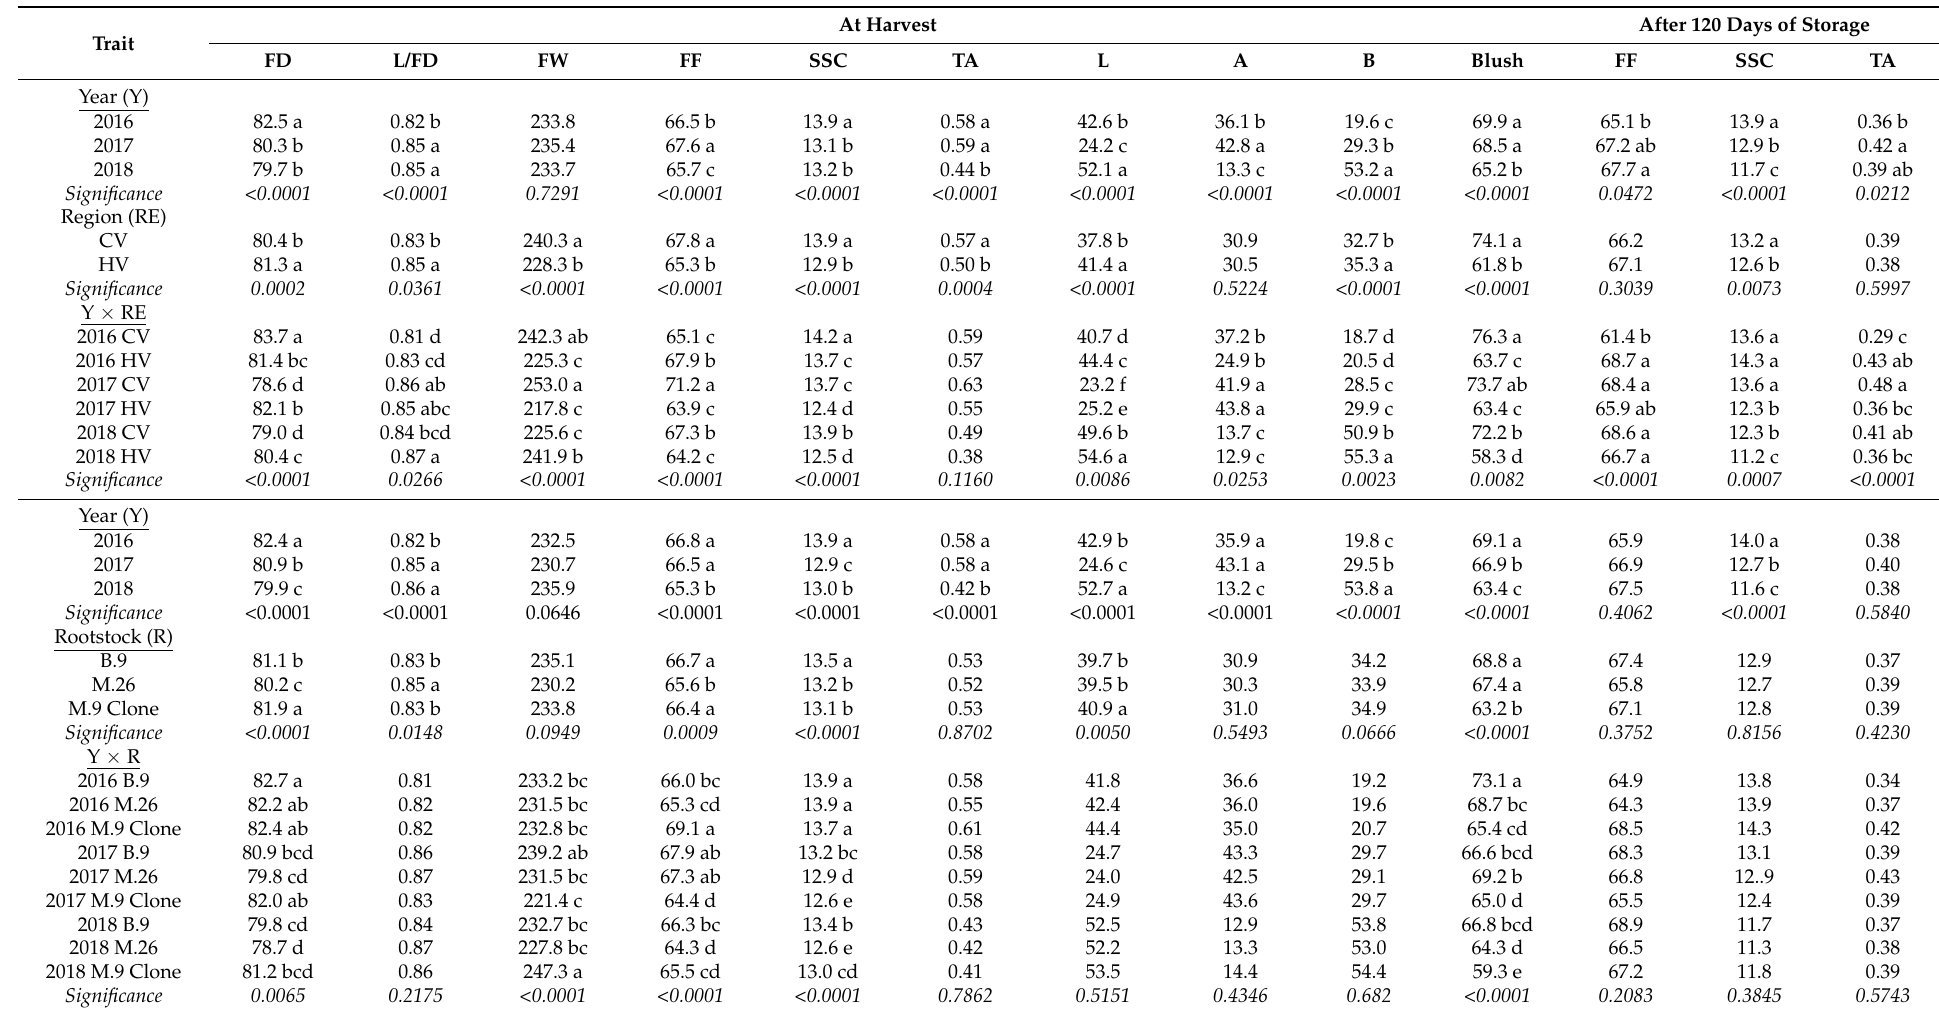
Table 6. Fruit quality of ‘Honeycrisp’ from each year, region, rootstock category and their interactions at harvest and postharvest time.